Question: Summarize what this figure shows in one sentence.
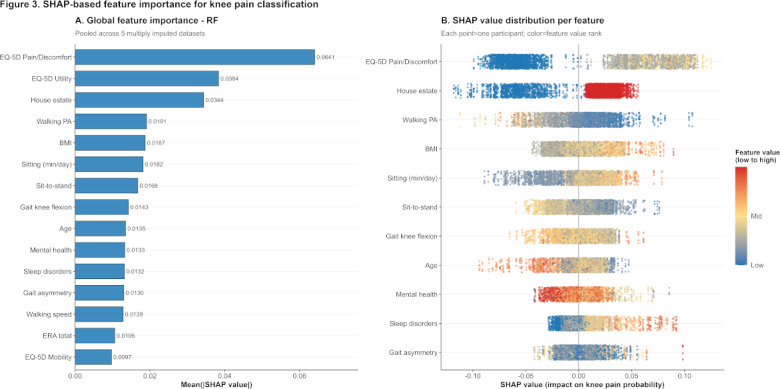
Answer: SHAP-based feature importance for knee pain classification. (A) Feature importance for mean absolute SHAP value for the top 15 features; (B) SHAP value distribution per feature (beeswarm plot). ERA: Expectations Regarding Aging; EQ-5D: EuroQol 5-Dimension; SHAP: Shapley Additive Explanations; BMI: body mass index; PA: physical activity.